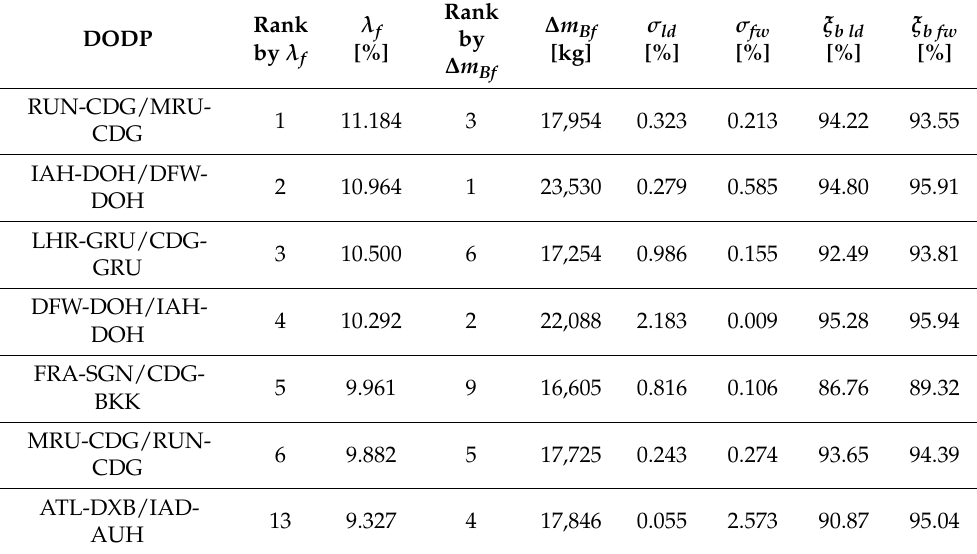
Table 3. Ranking of DODPs by λ f and ∆ m Bf for the ALL study and the FXD setting. DODP